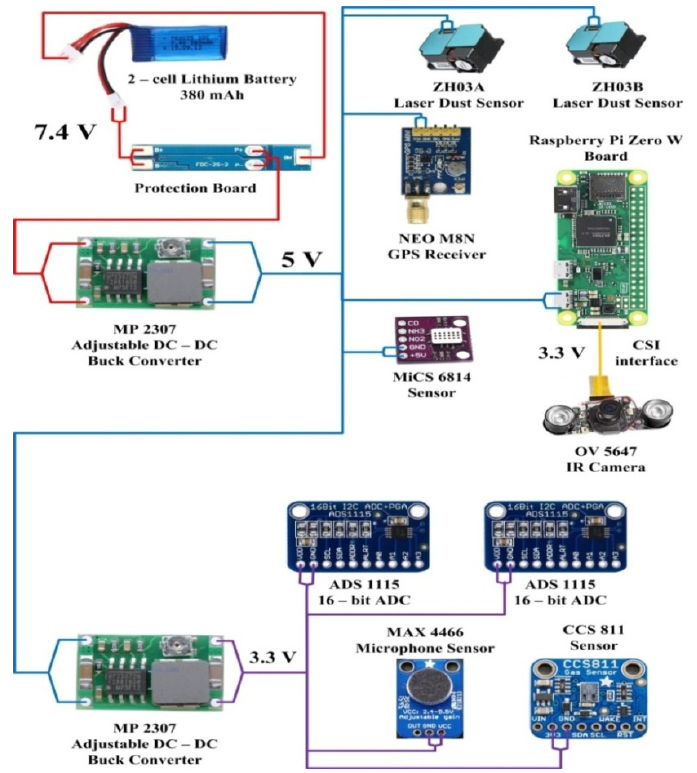
Figure 6. Physical connection scheme for supplying the various peripheral devices included in the developed sensing section.